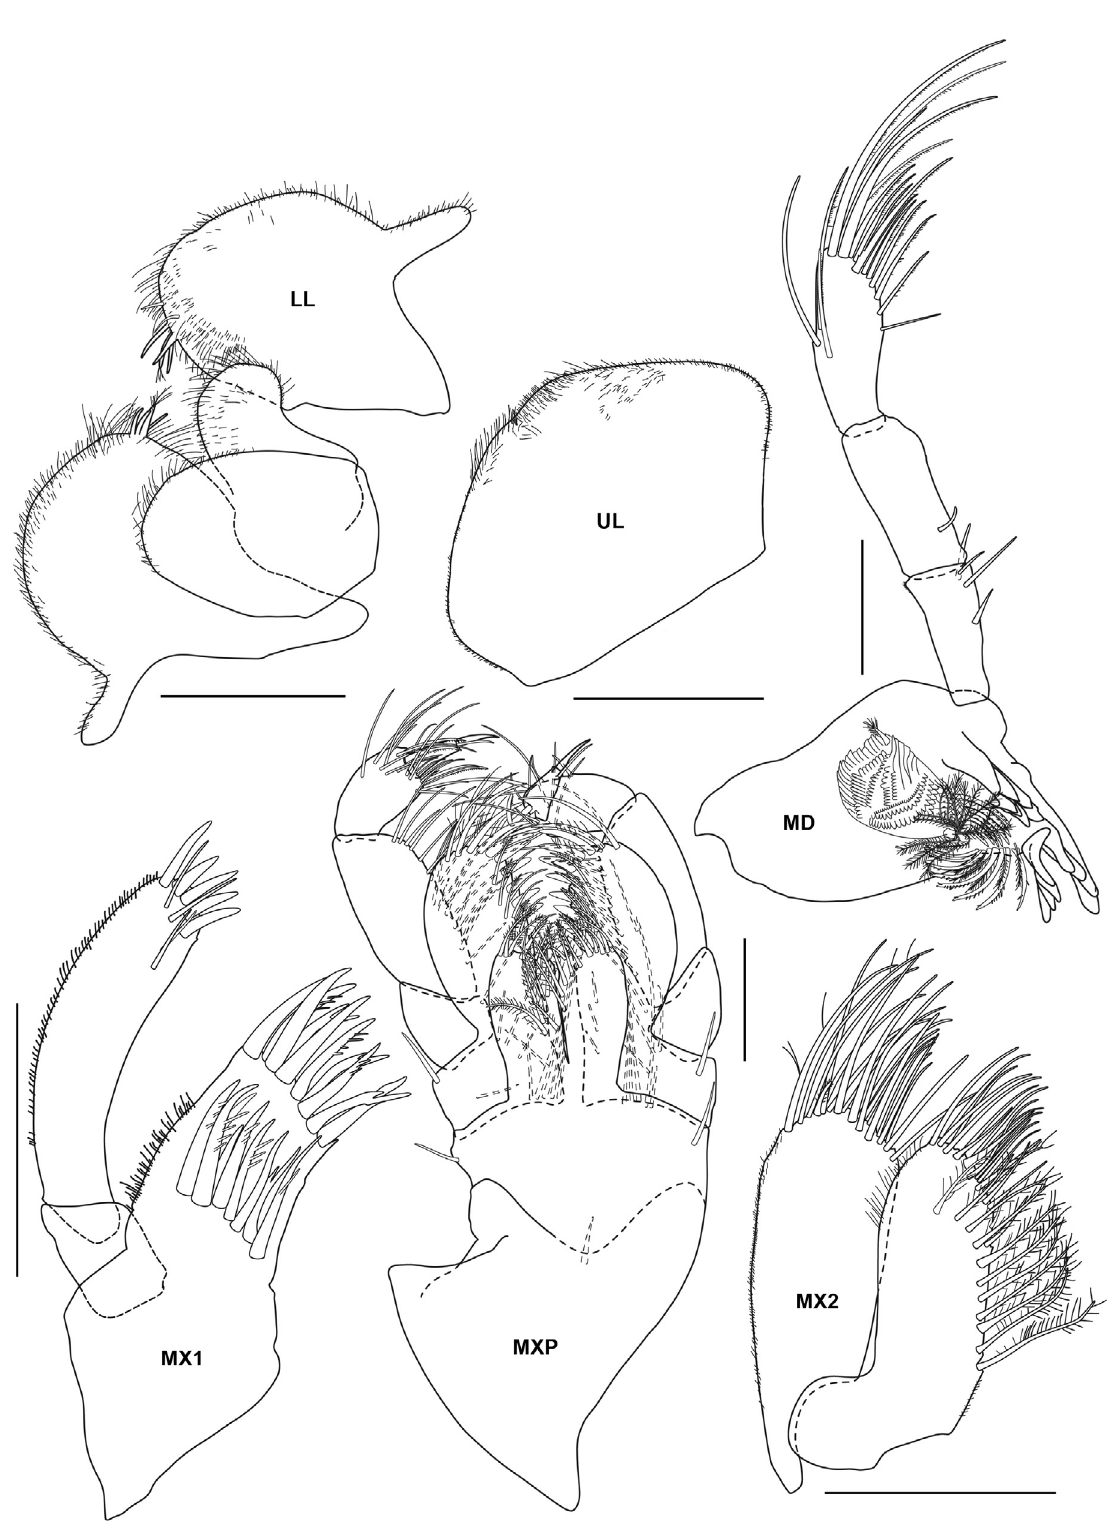
Fig. 8. Grandidierella pawaiensis sp. nov., allotype, ♀ (ZRC 2018.0494). Scale bars: 0.1